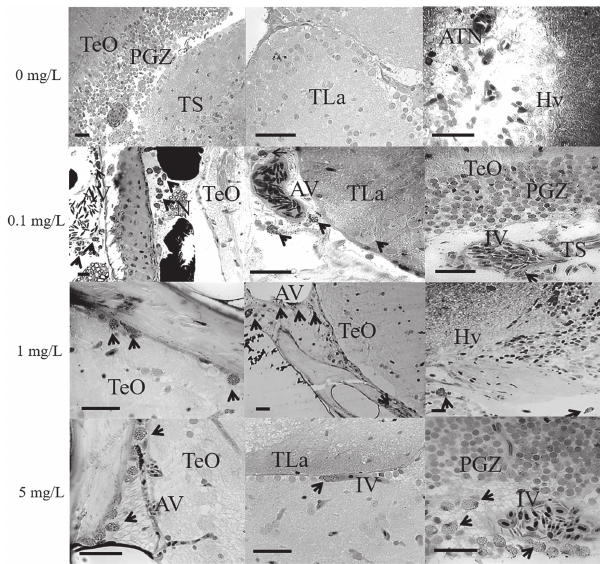
Fig. 3. Cross-sections of posterior diencephalic region (PDR) of Paracheirodon axelrodi for different treatments with Roundup Activo™. MC cells were found at different neuronal nuclei of posterior diencephalic area (PDR) in all treatments. Optic Tectum (TeO), gray periventricular area of optic tectum (PGZ), Torus semicircularis (TS), Torus lateralis (TLa), Hypothalamus with ventral are of periventricular hypothalamus (Hv) and anterior tuberal nucleus (ATN). Adjacent blood vessels (AV), internal blood vessels (IV), nerve (N). MC cells are shown by black arrows. Technique: high resolution optical microscopy (HROM). Bar 25